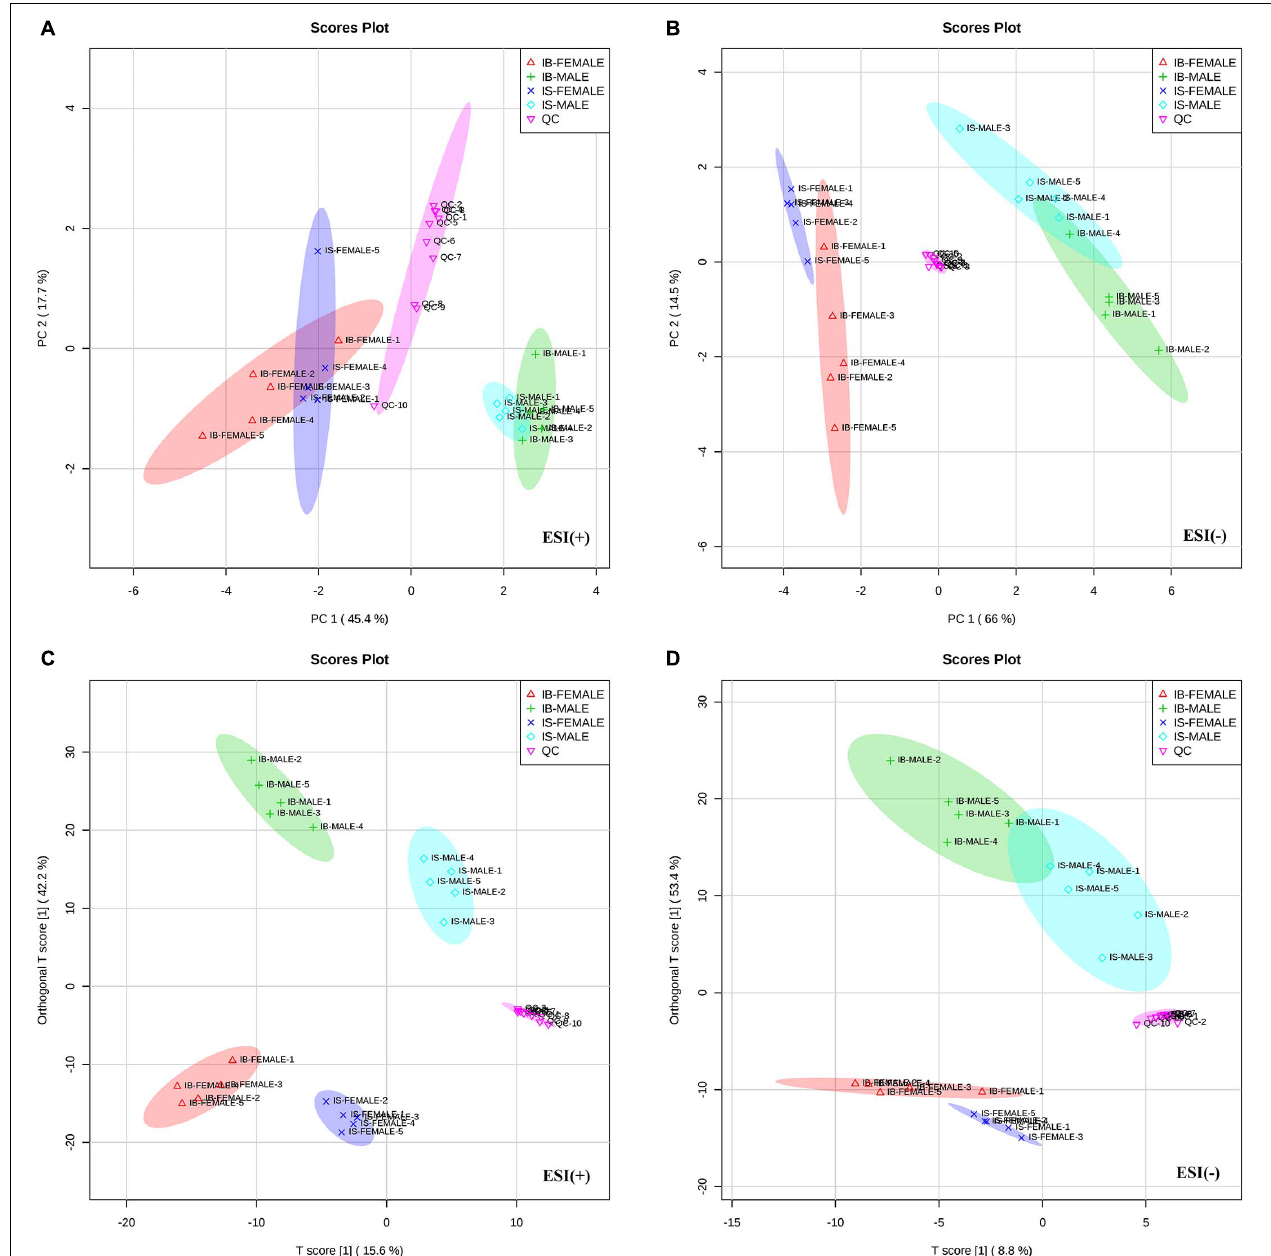
FIGURE 1 | Differential metabolic profiles of male and female S. japonicum worms between SCID mice and BALB/c mice at 35 days post infection. Principal Component Analysis (PCA) score scatter plots of metabolites obtained from LC-MS/MS fingerprints in ESI+ (A) and ESI- mode (B) . Partial least-squares discriminant analysis (PLS-DA) separating metabolites of the four groups of worms and QC sample in ESI+ (C) and ESI– mode (D) . IB-MALE denotes the male worms from BALB/c mice, which are marked with green plus sign. IB-FEMALE denotes the female worms from BALB/c mice, which are marked with red triangles. IS-MALE denotes the male worms from SCID mice, which are marked with blue diamonds. IS-FEMALE denotes the female worms from SCID mice, which are marked with purple cross. QC denotes the quality control samples, which are marked with pink triangles. The sample size is 5 in each group of worm samples.